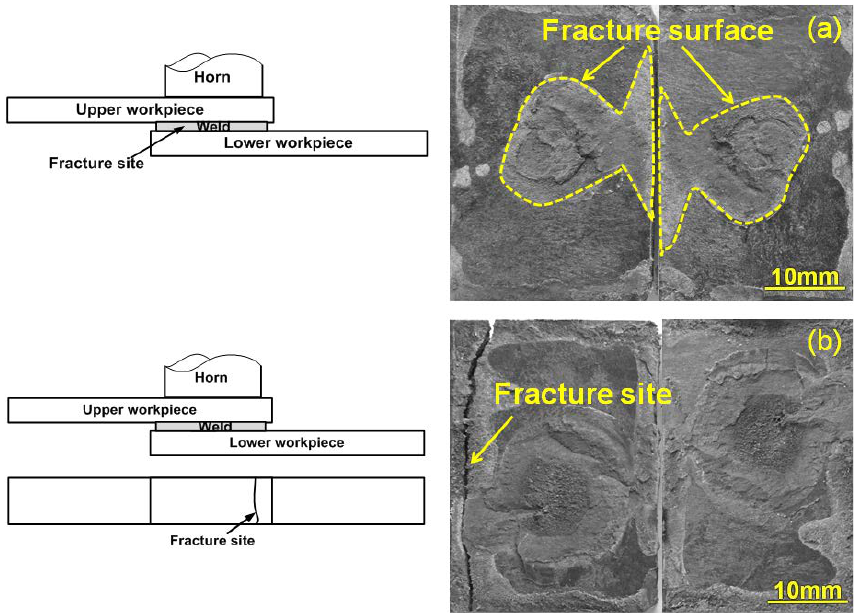
Figure 6. Failure modes for the ultrasonic welded 4 mm thick lap carbon fiber/polyamide 6 composite with 30 wt.% carbon fiber and without energy director: ( a ) interfacial failure; ( b ) mixed interfacial and workpiece fracture.